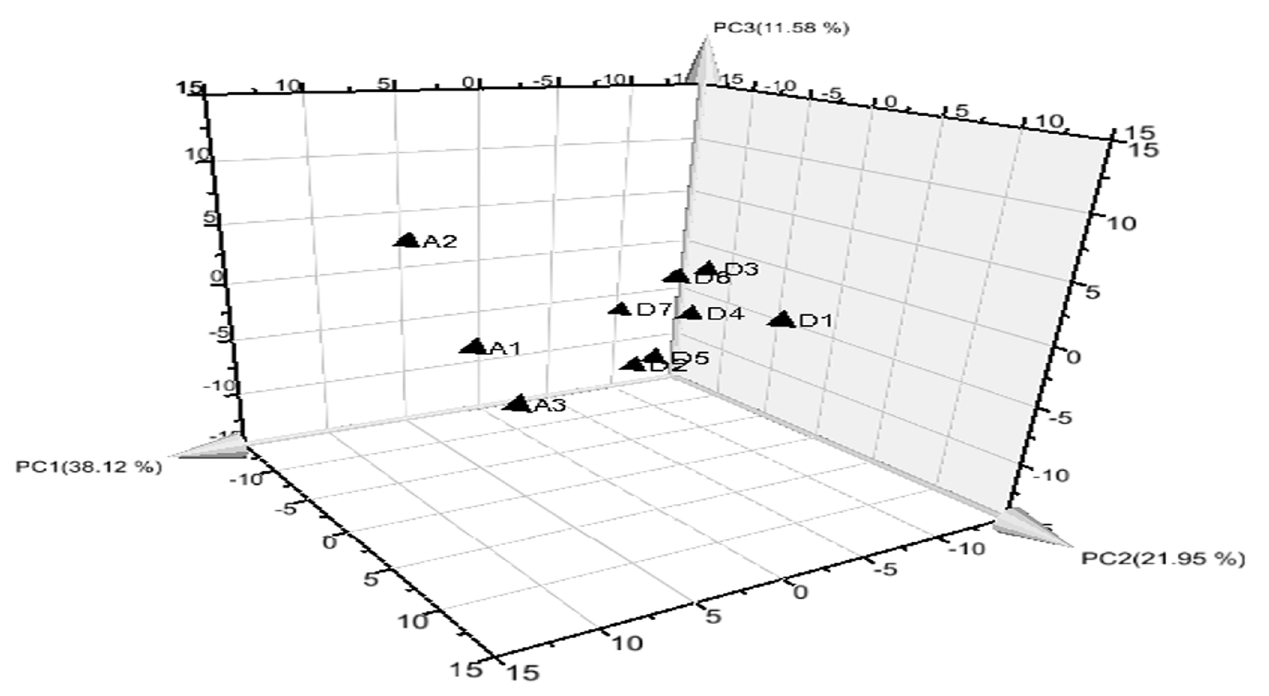
Fig. 4. Score scatter plot of tea samples on the first three principal components. D1–D7 stand for the different samples in Table 1, and A1–A3 stand for different Ya’an dark teas. Samples were divided into two parts (left and right), showed the differences between them was